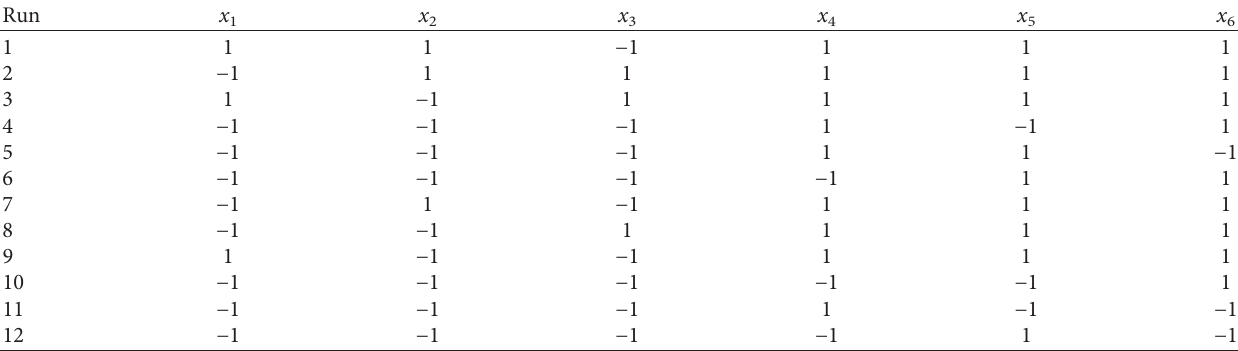
Table 2: Edge design of six factors and twelve runs.